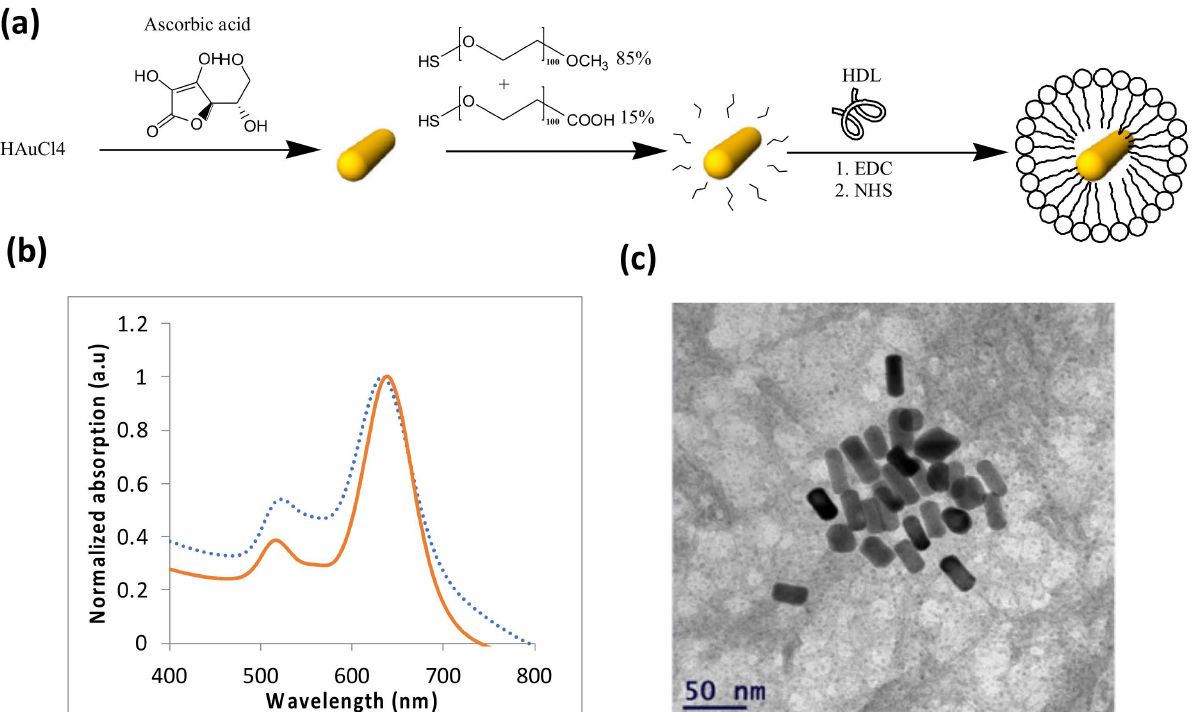
Figure 3. Characterization of GNRs. ( a ) Schematic diagram of the GNRs synthesis process and the coating of GNRs with m-PEG (85%) and COOH–PEG (15%), followed by covalent conjugation with HDL. ( b ) Optical properties of the GNRs: ultraviolet-visible spectroscopy of bare GNRs (solid line) and HDL coated GNRs (dotted line). ( c ) Transmission electron microscopy image of the GNRs. Average dimensions were 35 × 15 ± 2.2 nm ( n =